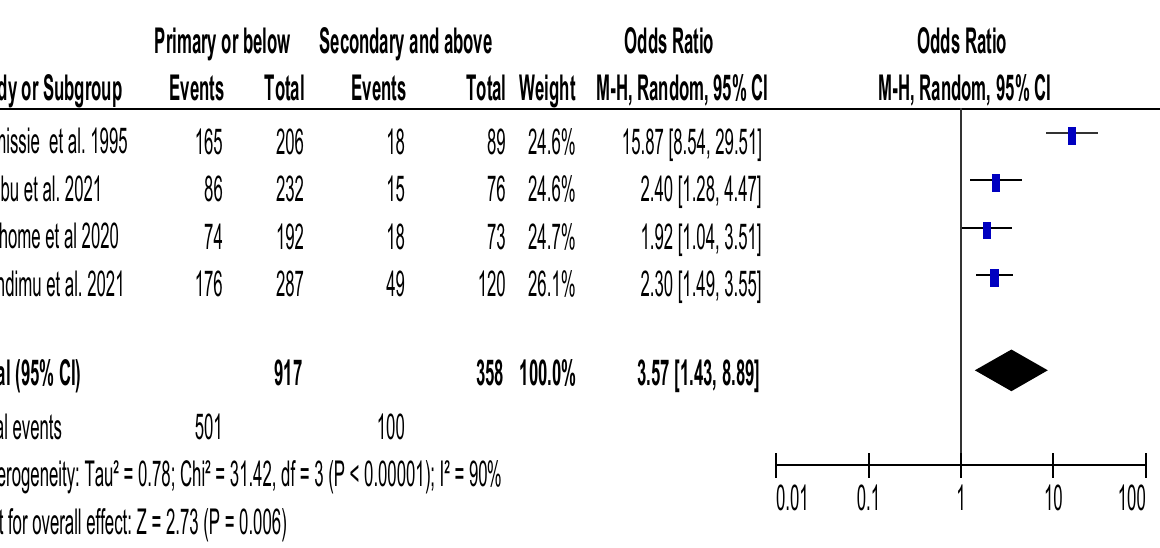
Figure 7. Forest plot using an unadjusted odds ratio for the association between education and food taboo practices among pregnant women in Ethiopia,